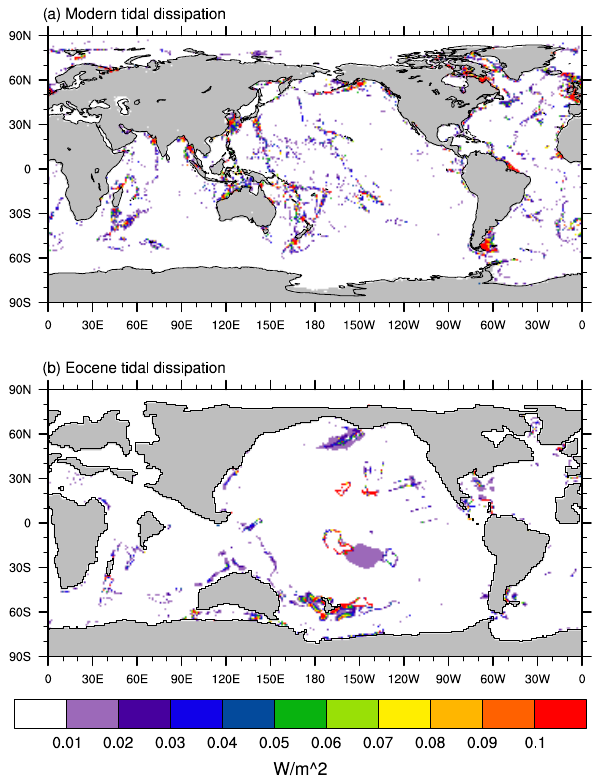
Figure 5. (a) Modern and (b) Eocene simulated tidal dissipation (Green and Huber,